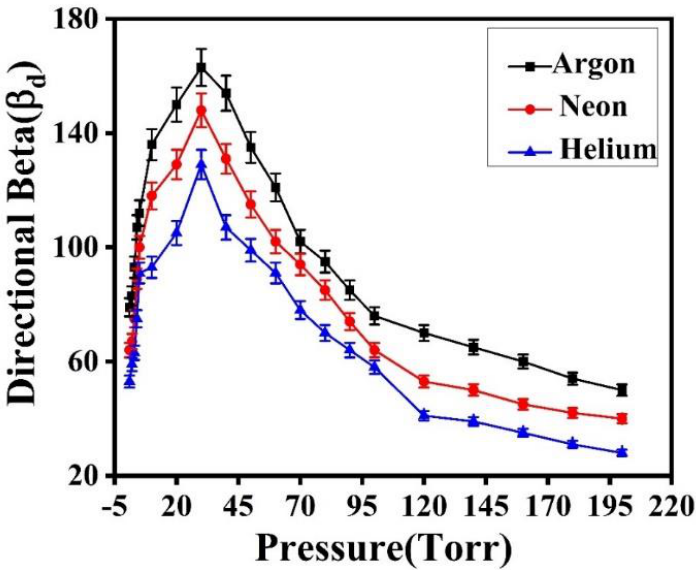
Figure 9. The fluctuation in directional beta of laser-induced Cu alloy plasma at different pressures in Ar, Ne, and He environments at 3.8 GW/cm 2 ns laser irradiation.